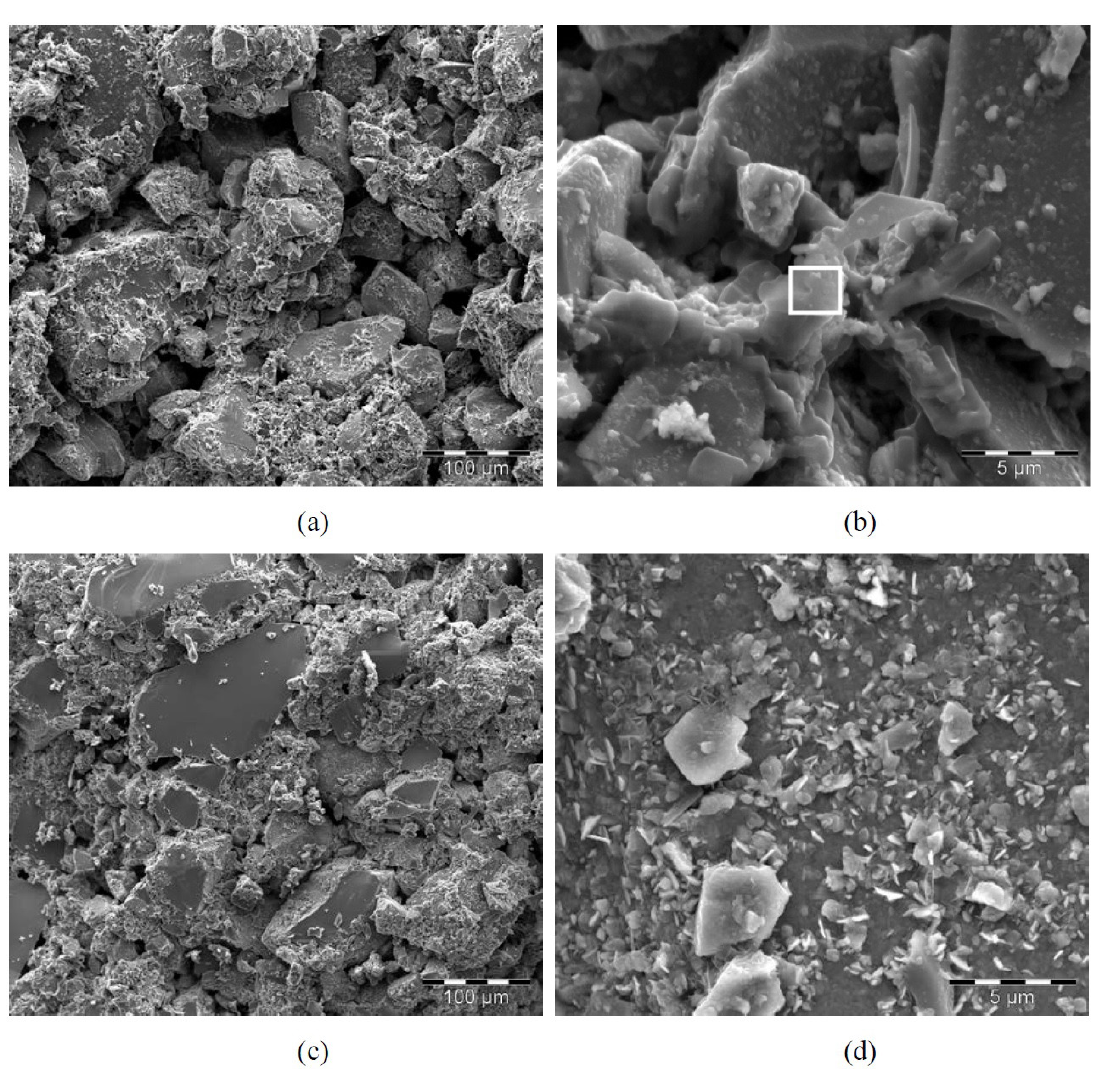
Figure 2. Backscatter SEM micrographs of the interiors of broken air-dried (a and b) and 800 °C sintered pellets (c and